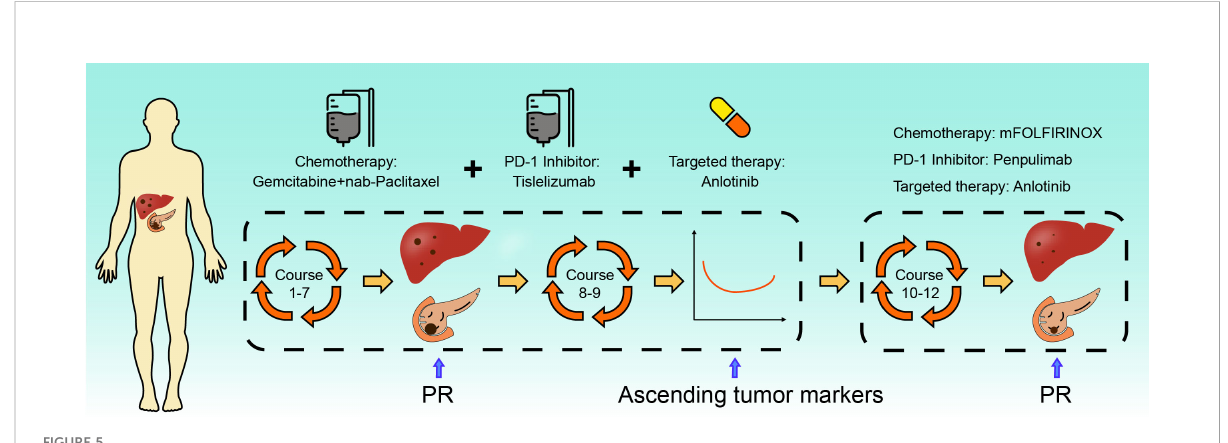
FIGURE 5 The schematic diagram for the patient timeline information.